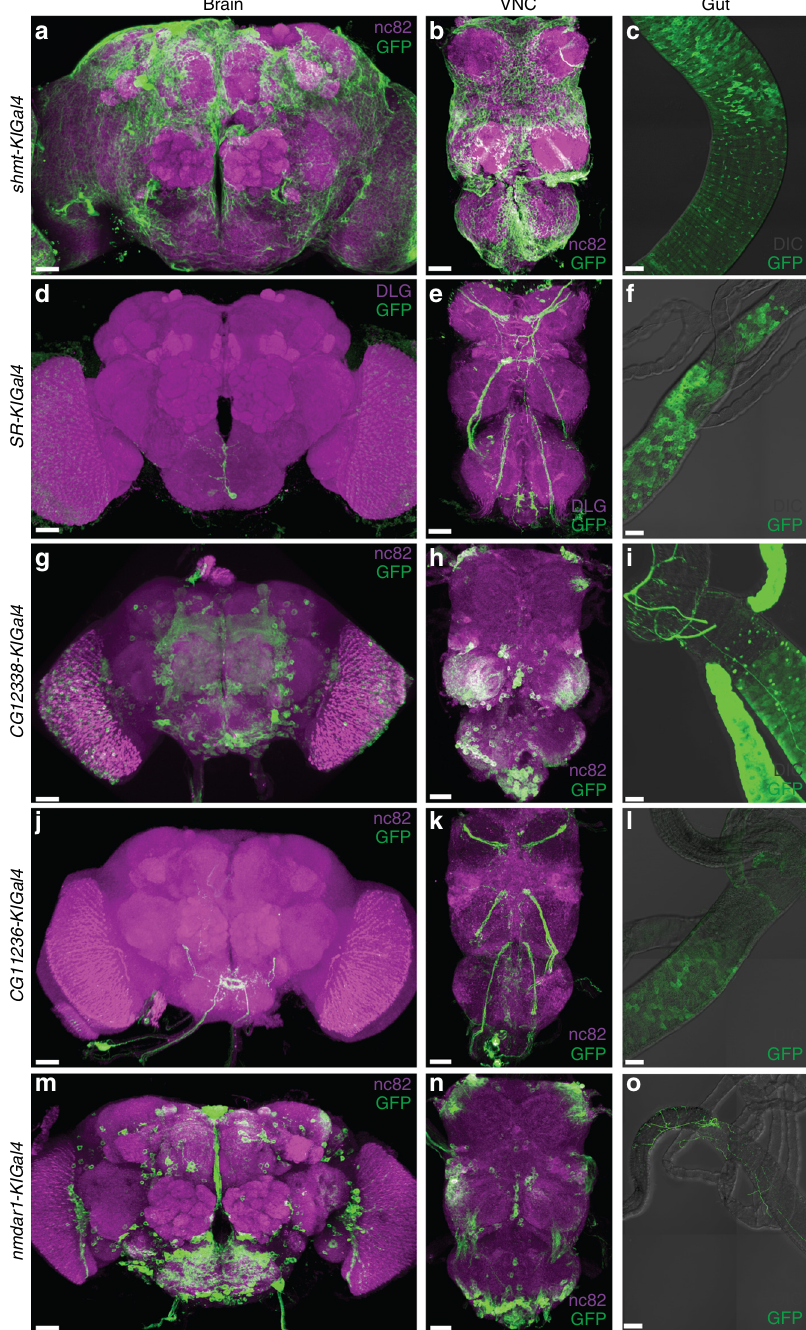
Fig. 5 Expression patterns of shmt , sr , daao , and nmdar1 . Expression patterns of shmt-KIGal4 ( a – c ), SR-KIGal4 ( d – f ), CG12338-KIGal4 ( g – i ), CG11236-KIGal4 ( j – l ), and nmdar1-KIGal4 ( m – o ) labeled by mCD8::GFP in the brain ( a , d , g , j , m ), the ventral nerve cord (VNC) ( b , e , h , k , n ), and the gut ( c , f , i , l , o ). The tissues were immunostained with anti-GFP and anti-DLG in ( d , e ), immunostained with anti-GFP in ( c , f , i , l , o ), immunostained with anti-GFP and nc82 in other panels. Scale bars are 30 μ